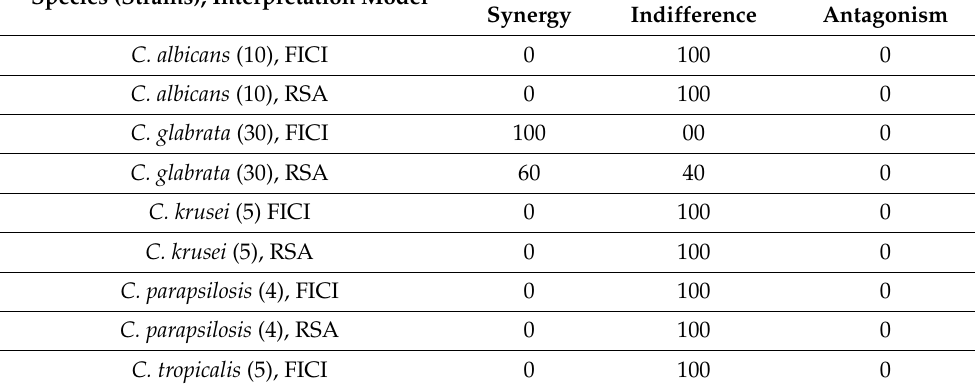
Table 3. Summary of the in vitro interactions of isavuconazole with isoquercitrin against common Candida species evaluated by checkerboard and interpretation by fractional concentration index and response surface